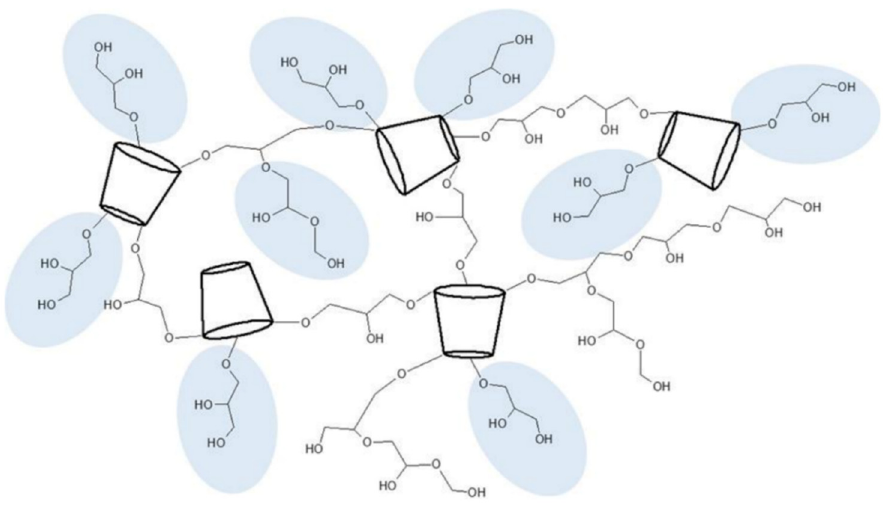
Figure 13. Scheme of the structures of β CDPs. The dihydroxypropyl side-chains (marked in blue) are formed in aqueous reaction systems, but are missing in the polymer prepared under solventless conditions.